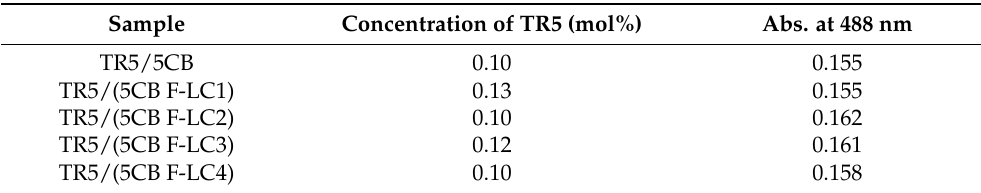
Table 1. The TR5 concentration and absorption at 488 nm of the samples.